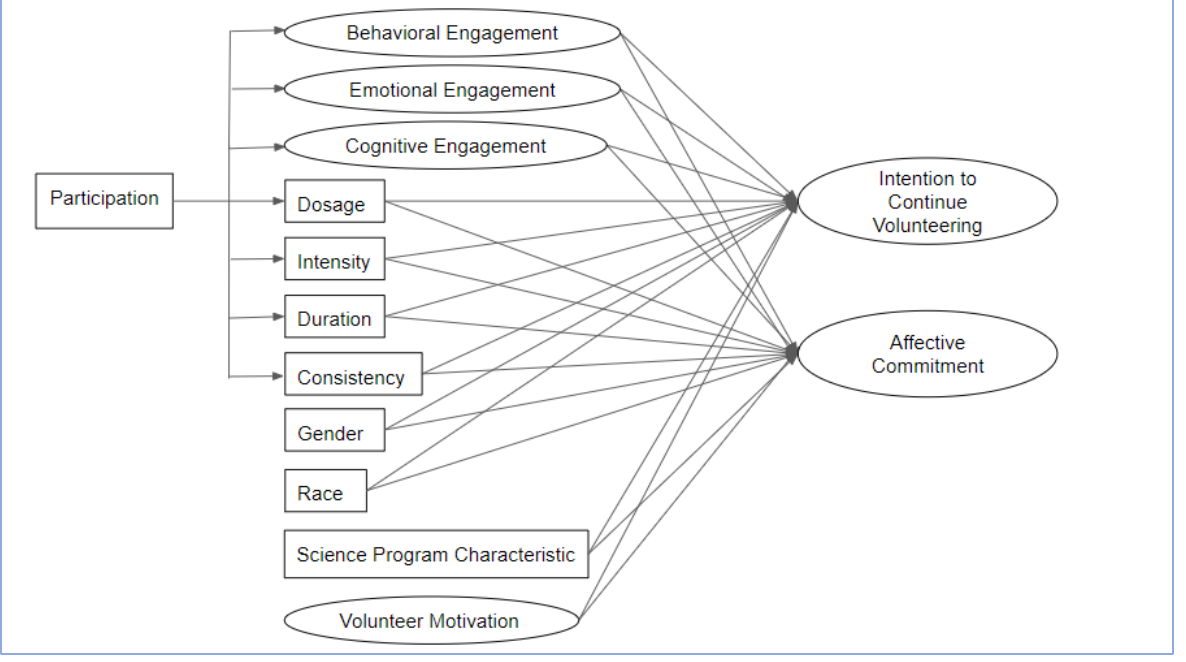
Figure 2. Hypothesized Correlations between the Variables as Outlined in this Study